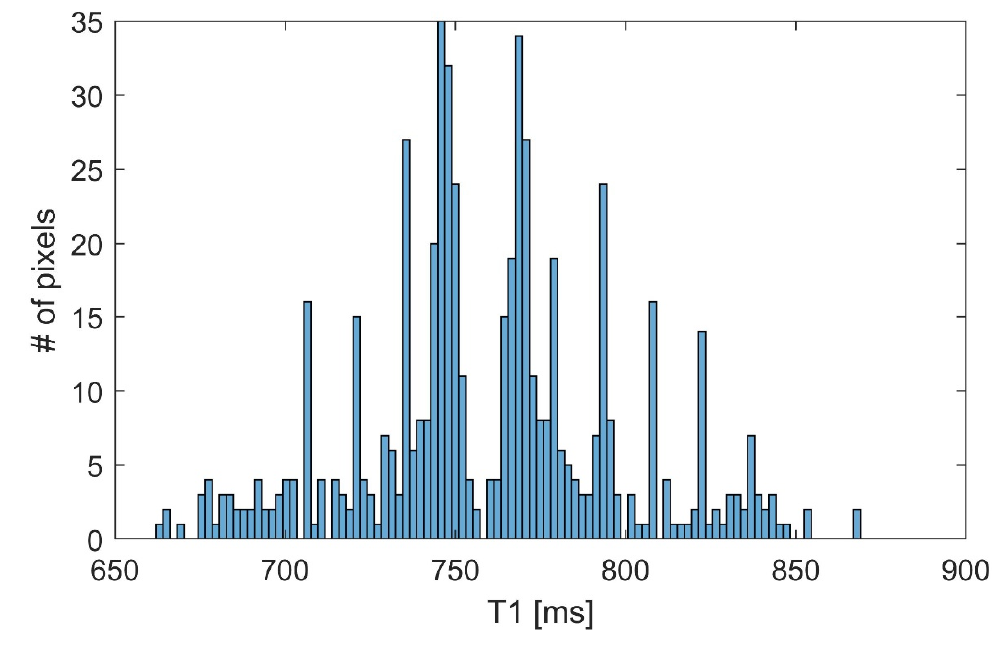
Figure 4. Histogram of estimated coefficients T 1 .